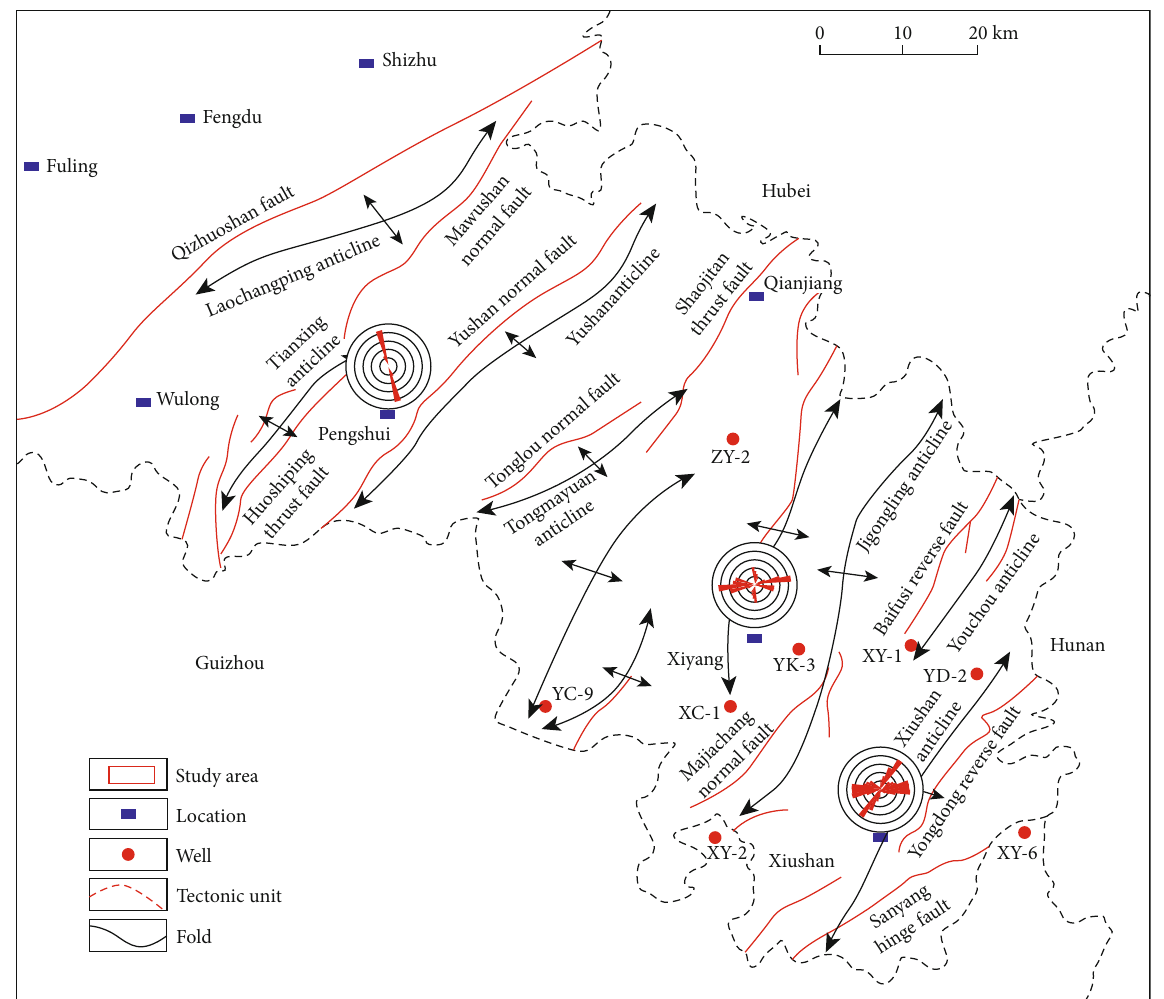
Figure 3: Strike rose diagrams of black shale fractures in the target layer of southeastern